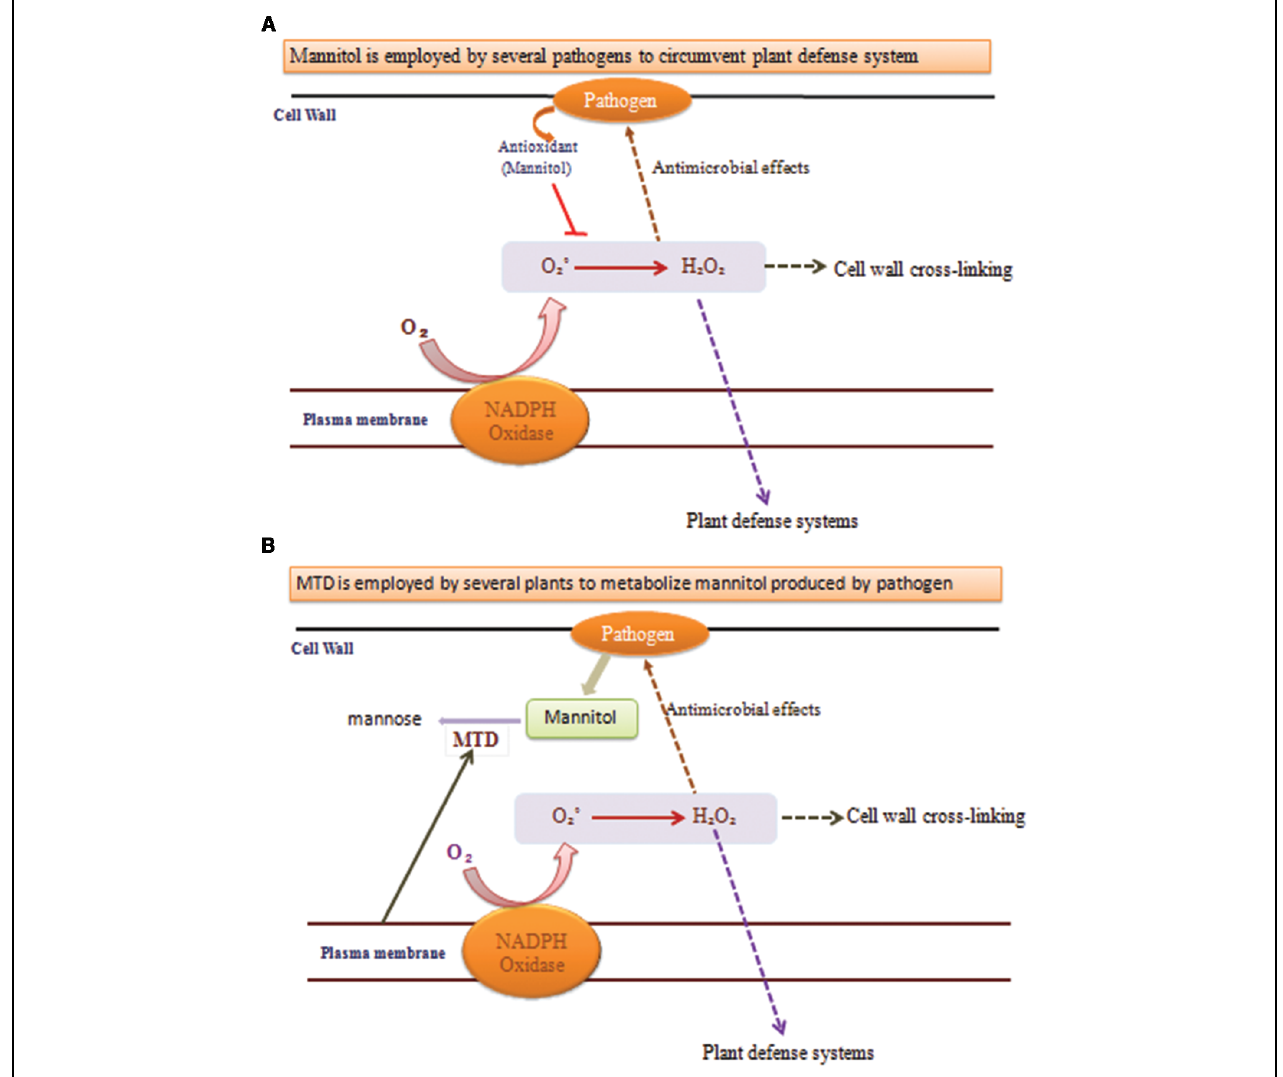
FIGURE 3 | Functions of mannitol and mannitol dehydrogenase (MTD) during plant–pathogen interactions. (A) When pathogens uses mannitol to circumvent plant defense system it quenches the ROS production and the processes marked with dotted arrows do not occur, leading to pathogen replication. (B) When plants use MTD to metabolize mannitol produced by pathogens then the processes marked with dotted arrows occur and provide resistance against the pathogen.